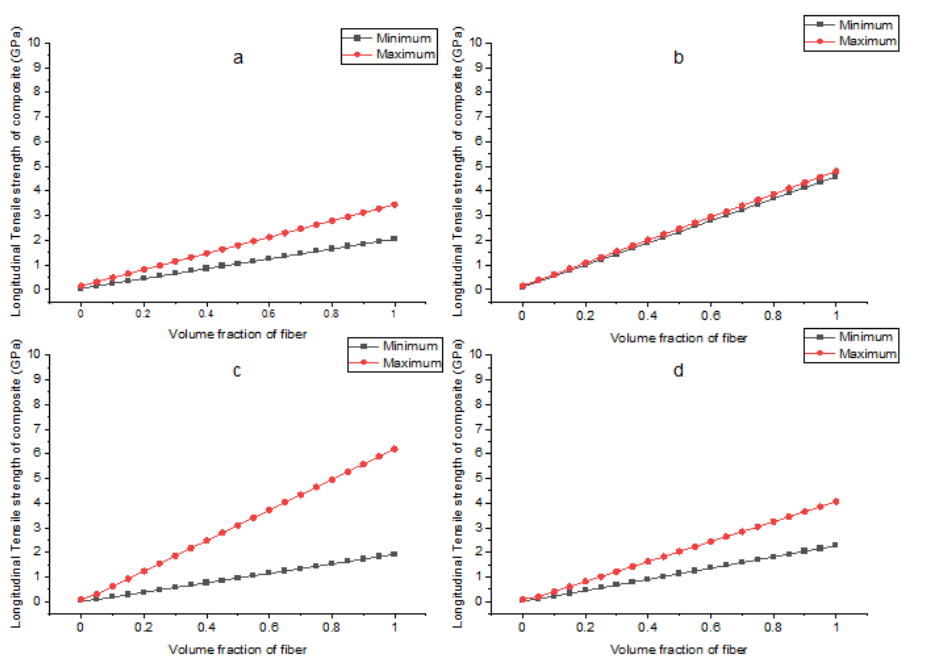
Figure A5. Depicts the variation in longitudinal tensile strength of ( a ) E-glass, ( b ) S-glass, ( c ) T300 carbon fiber and ( d ) AS carbon with volume of fiber. It can be seen that as the fiber ratio increases, the longitudinal tensile strength of the all the material increases. It is also noted that there is a linear increase in the modulus. For the carbon-fiber family, the increase in the modulus is far more compared to the glass-fiber family.